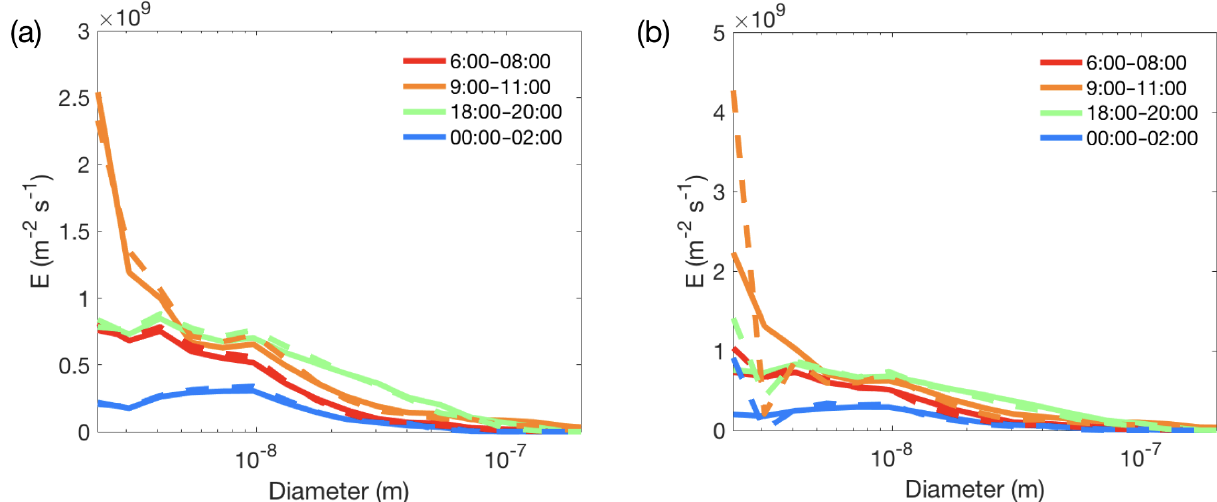
Figure 8. Average particle number emission size distributions for non-NPF event days assuming (a) GR = 3nmh − 1 (solid lines) and a GR that increases with size (dashed lines; see text for details) and (b) GR = 1 . 5nmh − 1 (solid lines) and GR = 6nmh − 1 (dashed lines). For the size distributions depicted on a logarithmic scale, see Fig. A7 in the Appendix.